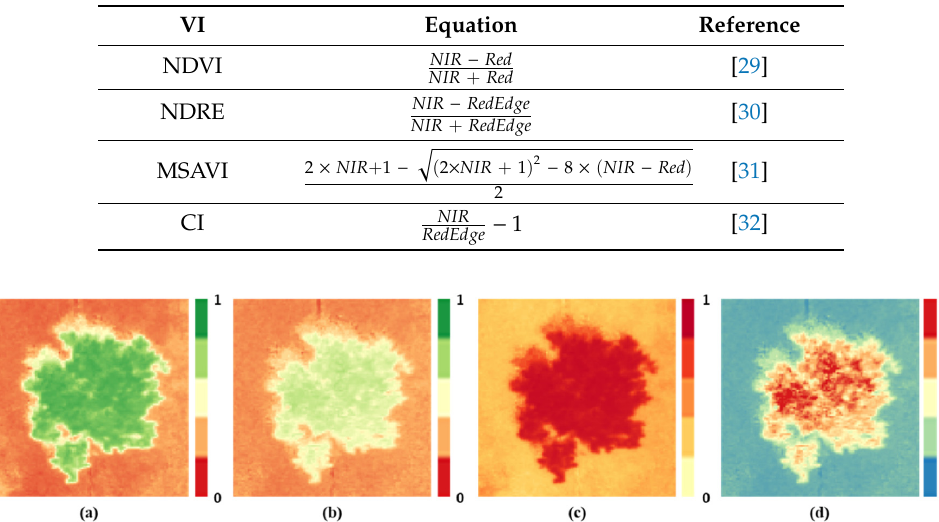
Table 3. Equations of vegetation indices (VIs).